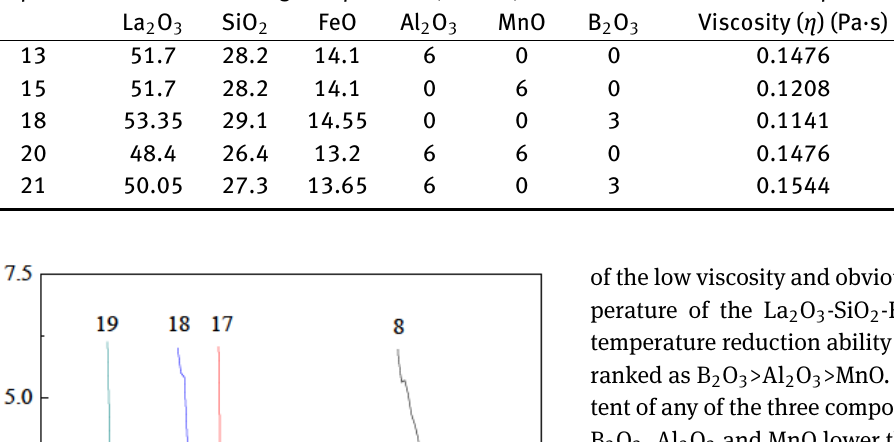
Table 5: Constant-Temperature Viscosity and Break Temperature of La 2 O 3 -SiO 2 -FeO-Al 2 O 3 -MnO and La 2 O 3 -SiO 2 -FeO-Al 2 O 3 -B 2 O 3 Slags. Sample No.